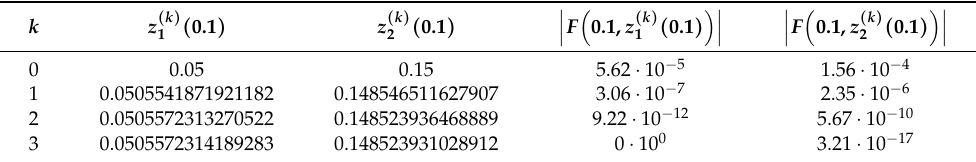
Table 3. Initial guess ( k = 0) and refinements of inner integration domain extremes, related to s = 0.1, and corresponding residual values for a parabolic curve parametrized by C ( s ) = ( s , s 2 ) , e i = [ 0,0.2 ] , ∆ hk =